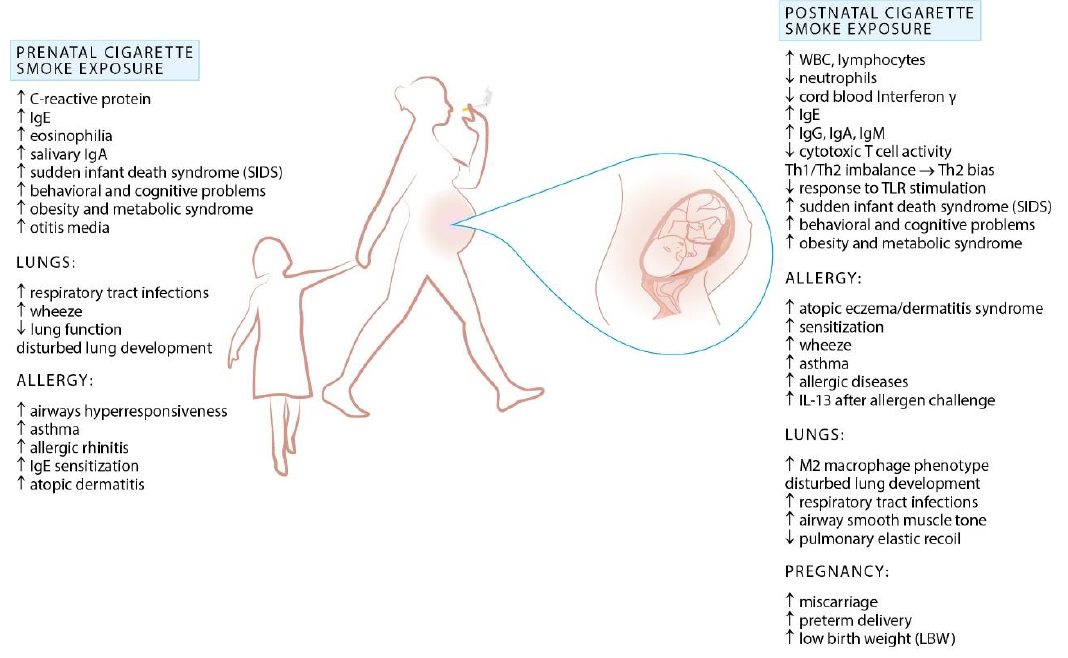
Figure 2. Effects of cigarette smoke exposure during prenatal life and early childhood.